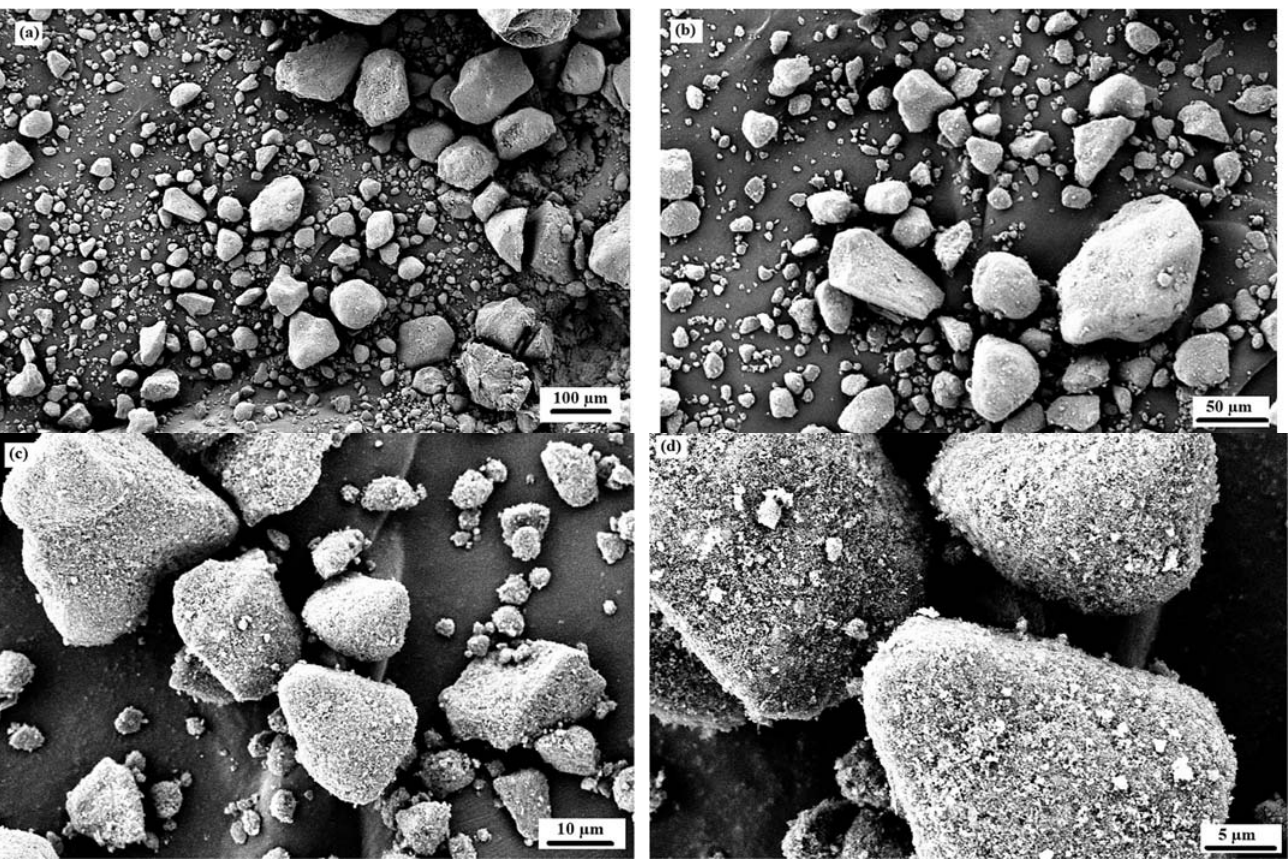
Figure 4. Micro-structure of rubber waste at various magnifications. ( a ) 100 µ m; ( b ) 50 µ m; ( c ) 10 µ m; Figure 4. Micro ‐ structure of rubber waste at various magnifications. ( a ) 100 μ m; ( b ) 50 μ m; ( c ) 10 μ m; ( d ) 5 μ m